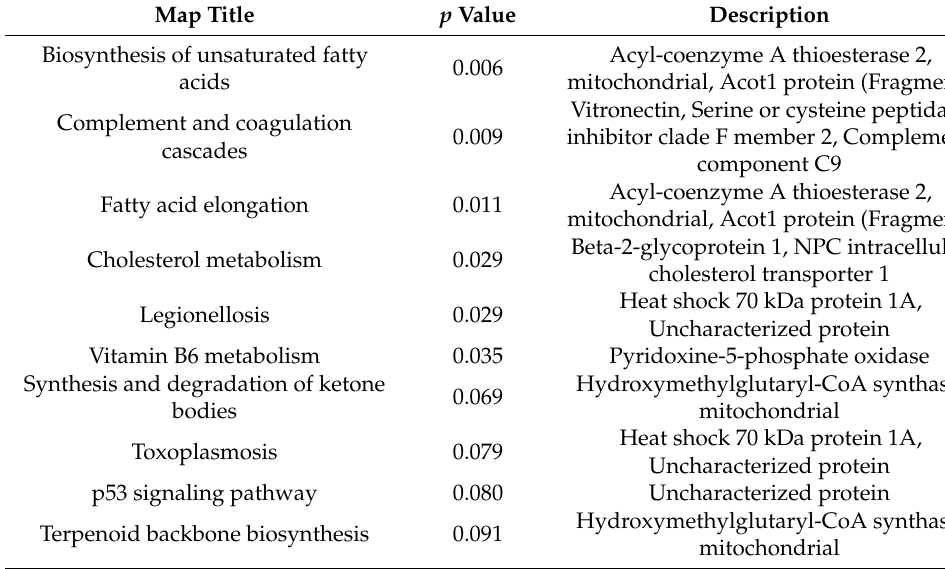
Table 4. The major KEGG pathways and related